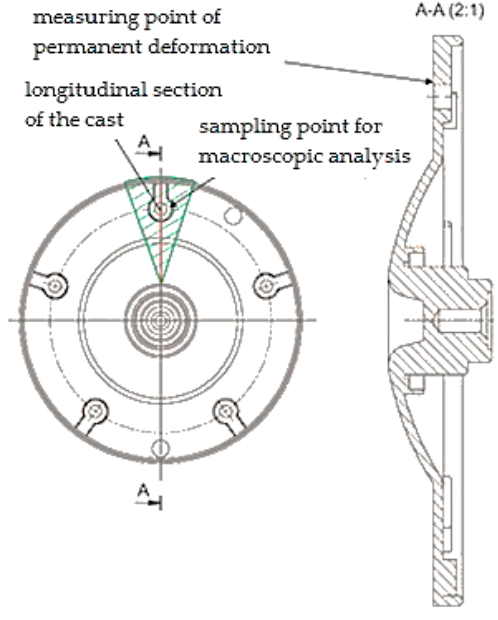
Figure 1. Measuring points of mechanical properties.